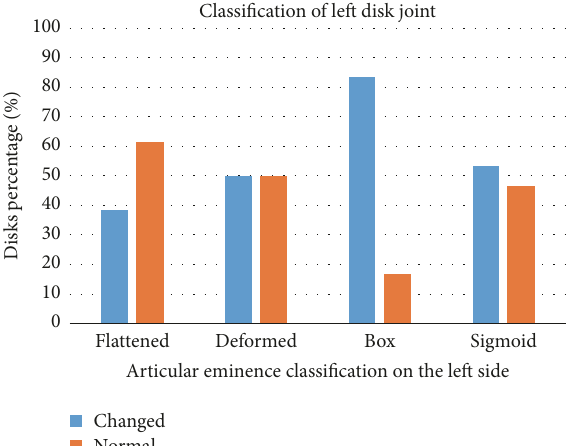
Figure 5: Association between the morphology of the left articular eminence with the disk classification on the left side.